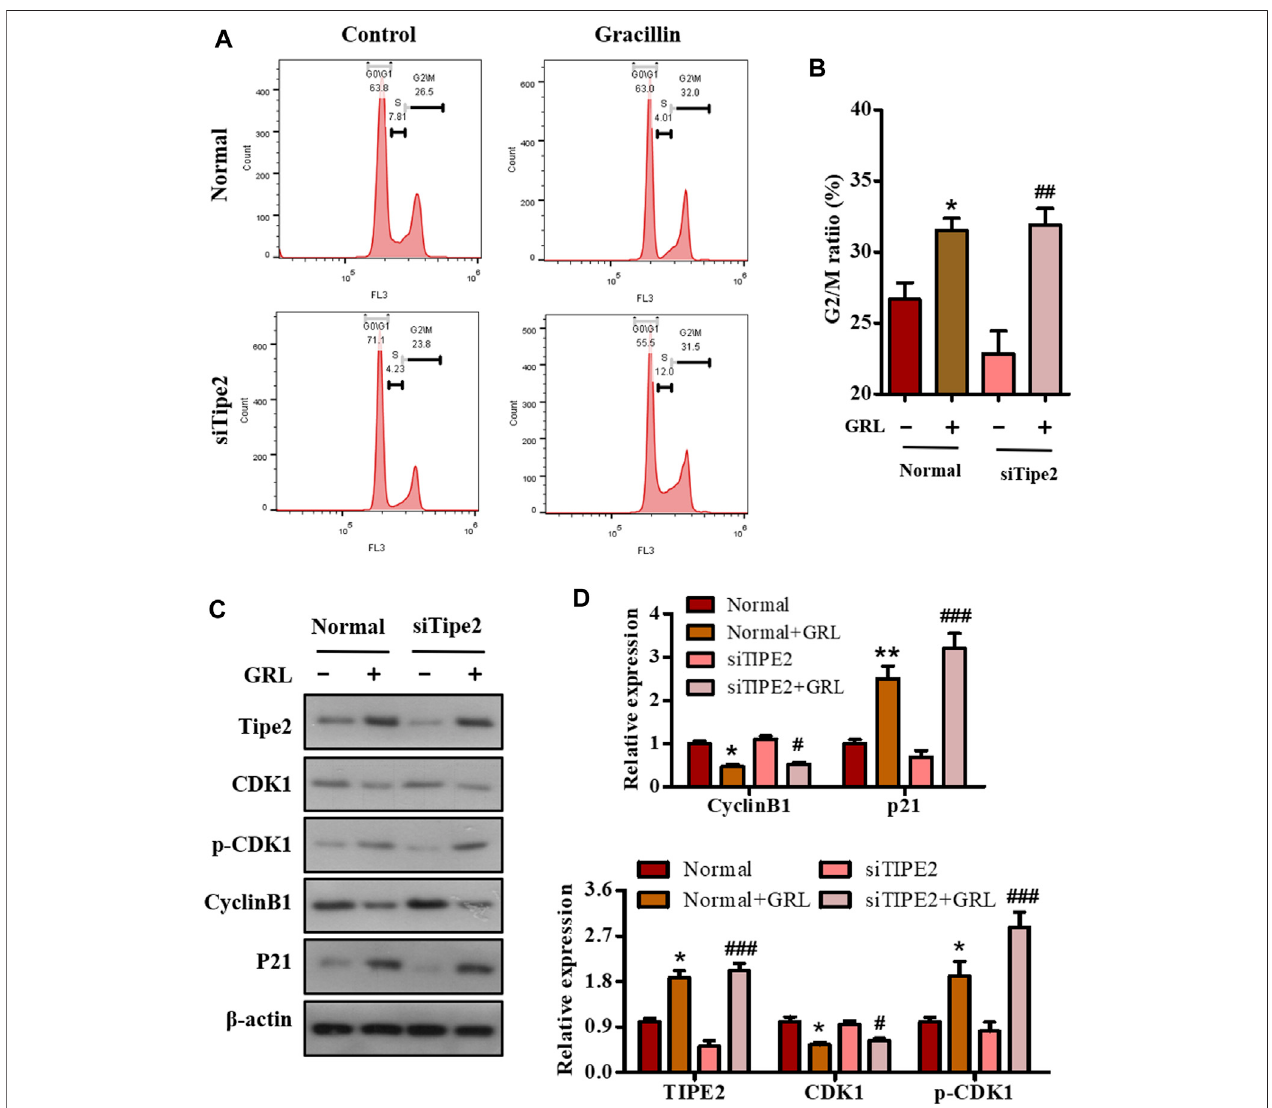
FIGURE 5| The role of TIPE2 in the cell cycle distribution mediated bygracillin in BGC823 cells. (A) Flow cytometry for cell cycle distribution byTIPE2 and gracillin. BGC823 cells and TIPE2 siRNA BGC823 cells were maintained with FBS-free medium for 36 h, then treated with 3 μ M gracillin for another 24 h. (B) The quantitative analysisofcellcycledistributionbyTIPE2 and gracillin. (C) Western blot fortheexpression ofTIPE2, CDK1, p-CKD1,cyclin B1,and p21. (D) The quantitative analysisof protein expression. The values of the histogram were displayed as mean ± SD. 0.01 < p < 0.05 (*) represents a signi fi cant difference and 0.001 < p < 0.01 (**) represents a very signi fi cant difference to the normal control; 0.01 < p < 0.05 ( # ) represents a signi fi cant difference, 0.001 < p < 0.01 ( ## ) represents a very signi fi cant difference and p < 0.001 ( ### ) represents an extremely signi fi cant difference to the TIPE2 siRNA